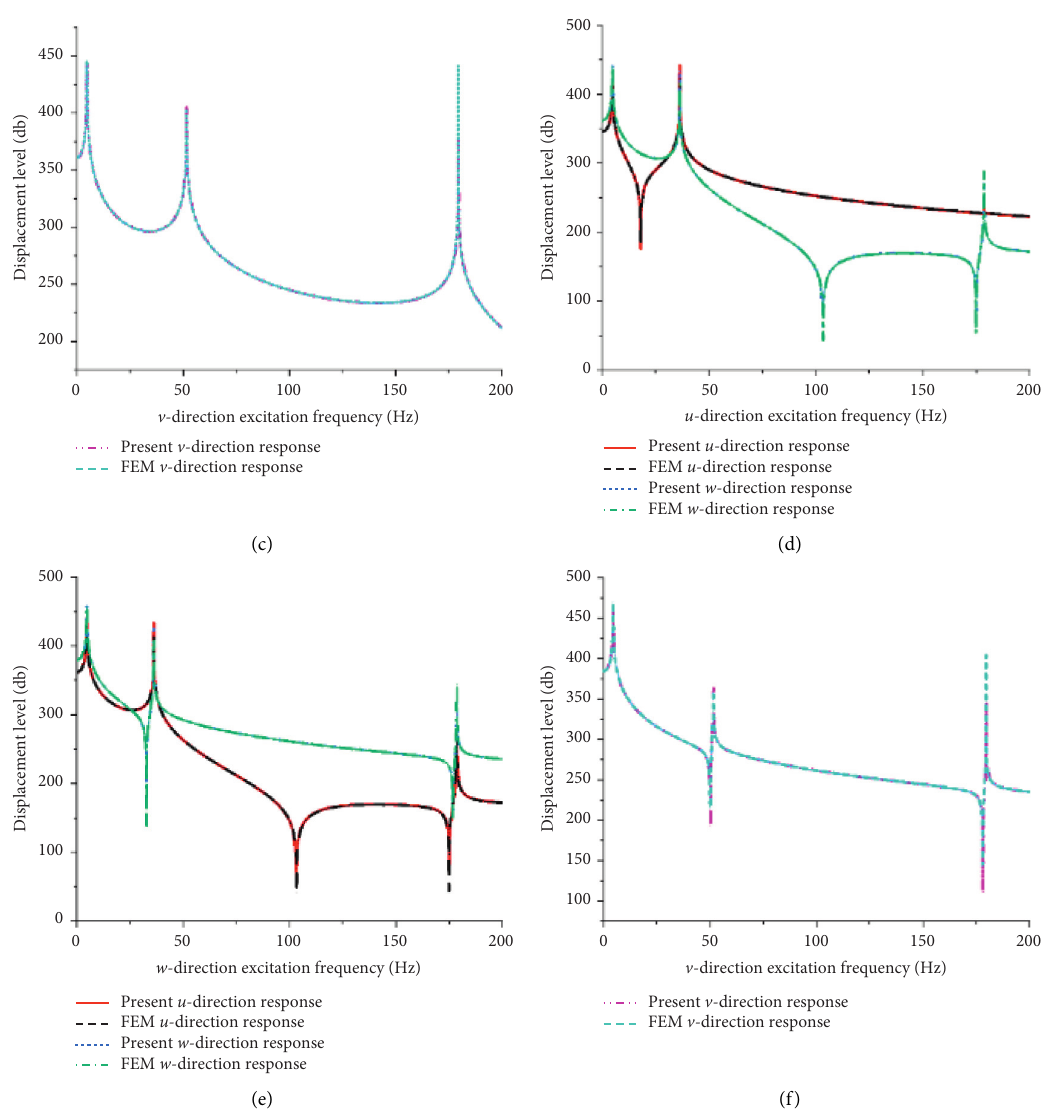
Figure 5: Comparison of forced response at midpoint and mass point of the curved beam. (a) u- direction displacement responses at the midpoint of the beam. (b) The w- direction displacement responses at the midpoint of the beam. (c) The v- direction displacement responses at the midpoint of the beam. (d) u- direction displacement responses at the mass point of the beam. (e) The w- direction displacement responses at the mass point of the beam. (f) The v- direction displacement responses at the mass point of the